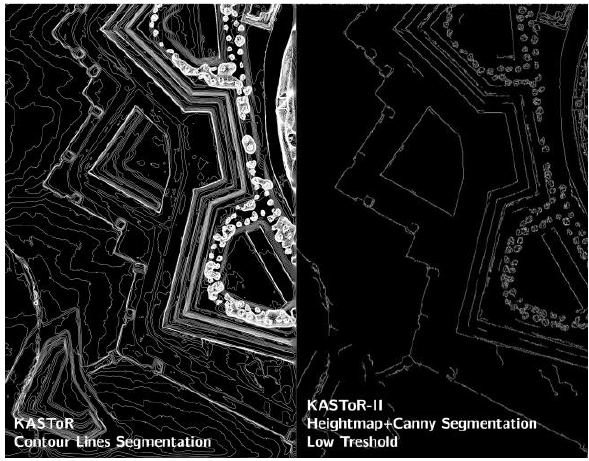
Figure 3. Geometric segmentations